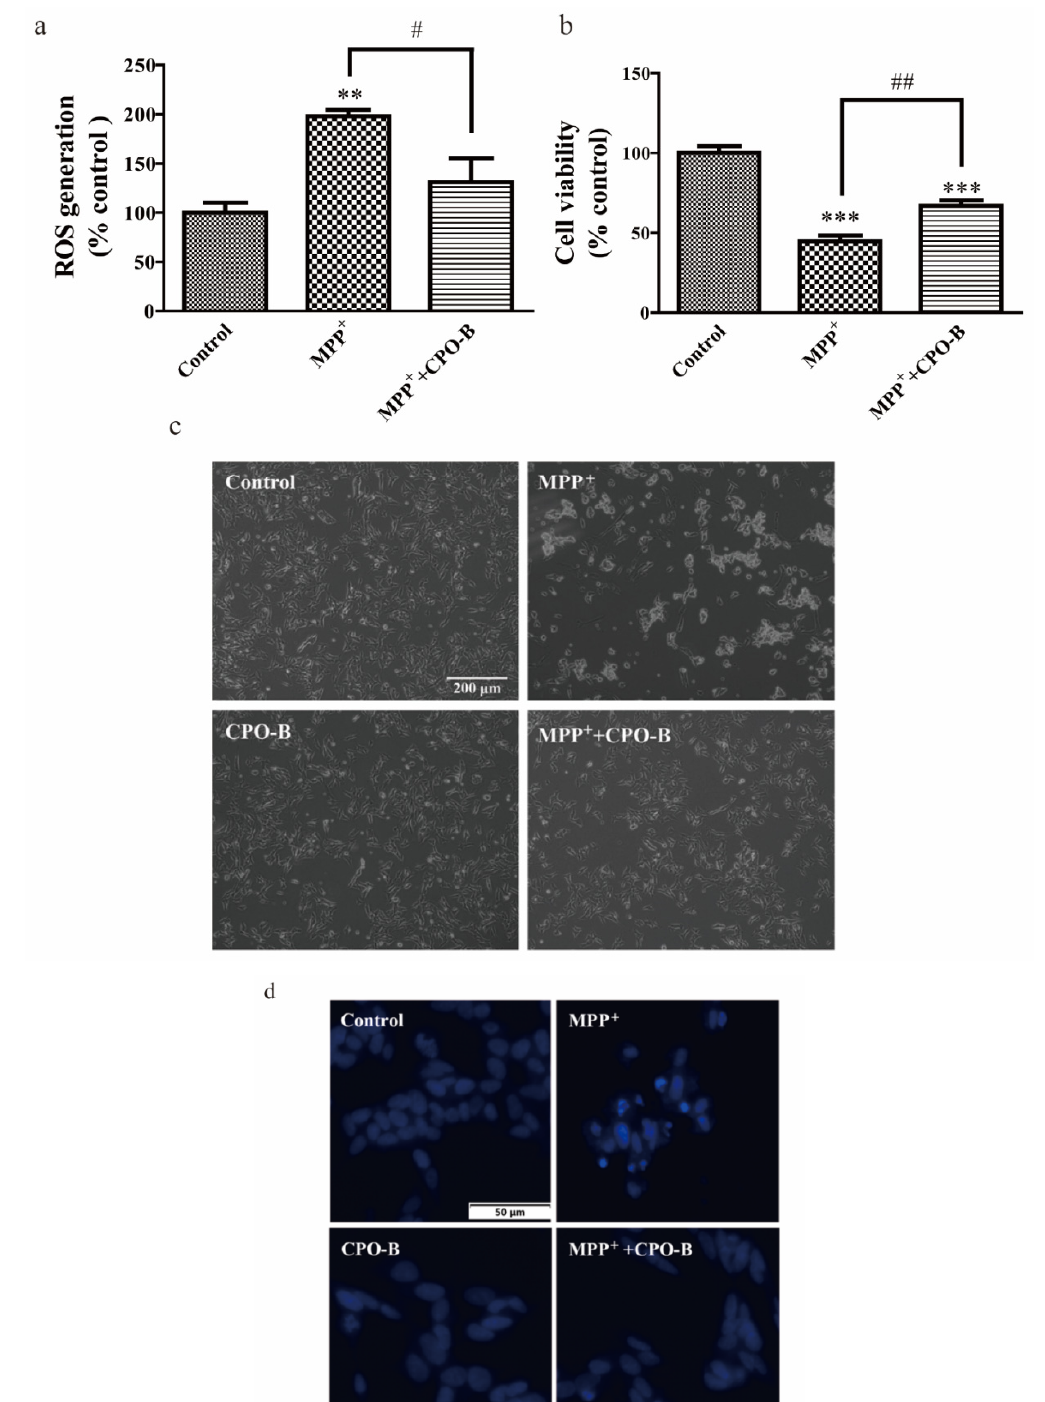
Figure 1. The effect of CPO-B on MPP + -induced cytotoxicity measured by intracellular ROS generation ( a , n = 4), cell viability ( b , n = 8) , microscopic examination ( c ) and Hoechst nuclear staining ( d ); the values (mean ± SEM) were standardized to the percentage of control; symbol * indicates the difference between control and other treatments; symbol # indicates the difference between MPP + and MPP + +CPO-B; ** p < 0.01, *** p < 0.001, # p < 0.05, ## p < 0.01; CPO-B, B-type cinnamon procyanidin oligomer; MPP + , 1-methyl-4-phenylpyridinium. 2.3. CPO-B Blocks MPP + -Induced Alteration of Apoptosis-Associated Proteins in SH-SY5Y Cells